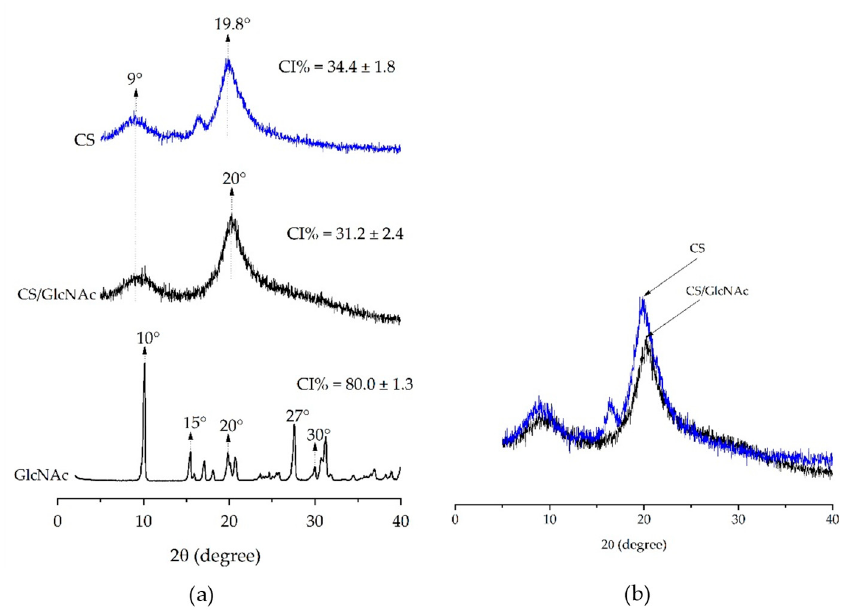
Figure 4. XRD patterns of ( a ) the GlcNAc, CS, and CS / GlcNAc wet-spun filaments, and a ( b ) comparison of the intensity values.